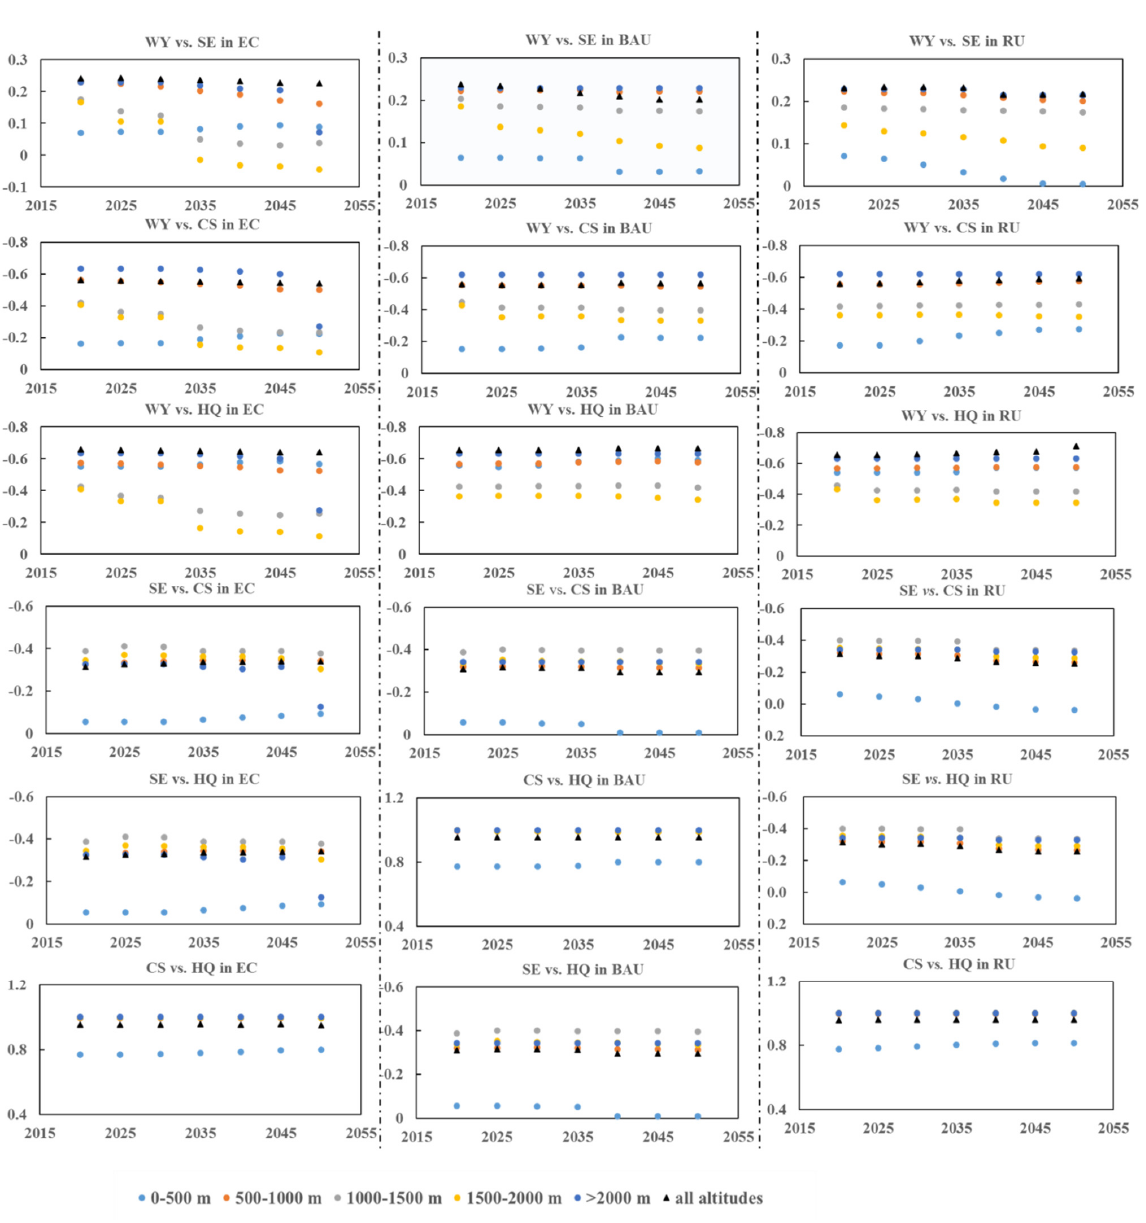
Figure 9. Variation of the relationship between ecosystem services from 2020 to 2050. Notes: EC represents ecological conservation (right-most column). RU represents rapid urbanization. BAU represents business as usual. WY refers to water yield, SE to soil export, CS to carbon storage, and HQ to habitat quality. WY vs. CS in EC represents the relationship between water yield and carbon storage in the ecological conservation scenario. The different colored dots represent the relationships between ecosystem services at different altitudes. The black triangles indicate the relationships between ecosystem services for the whole region. The numbers on the Y-axis of each figure are the Pearson’s correlation coefficients between pairs of ESs.